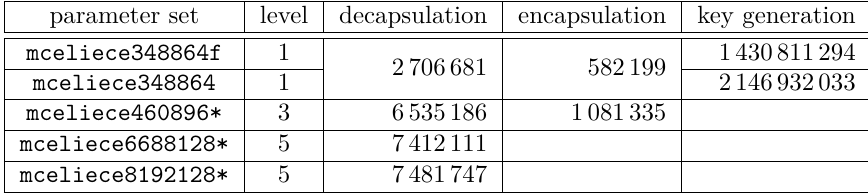
Table 1: Cycle counts for encapsulation and decapsulation in our implementation. We use * to mean both the “non-f” parameter set (simply removing * ) and the corresponding “f” parameter set (replacing * by f). Note that a non-f parameter set and the corresponding f parameter set share the same encapsulation and decapsulation algorithms. The cycle counts for encapsulation and key generation are average numbers of 100 measurements. All the cycle counts are measured at the maximum frequency 168 MHz. Table 12 shows cycle counts measured at 24